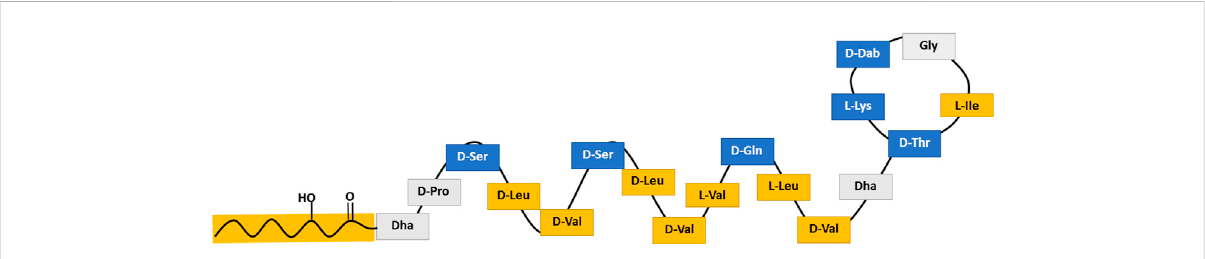
FIGURE 1 Schematic structure of tolaasin II representing the amphipathic α -helical golf-club conformation assumed for tolaasin II. Blue stands for amino acids with low hydrophobicity, yellow for those with high hydrophobicity and gray for those with a hydrophobicity value close to zero according to the scale of Kyte and Doolittle (Kyte and Doolittle,